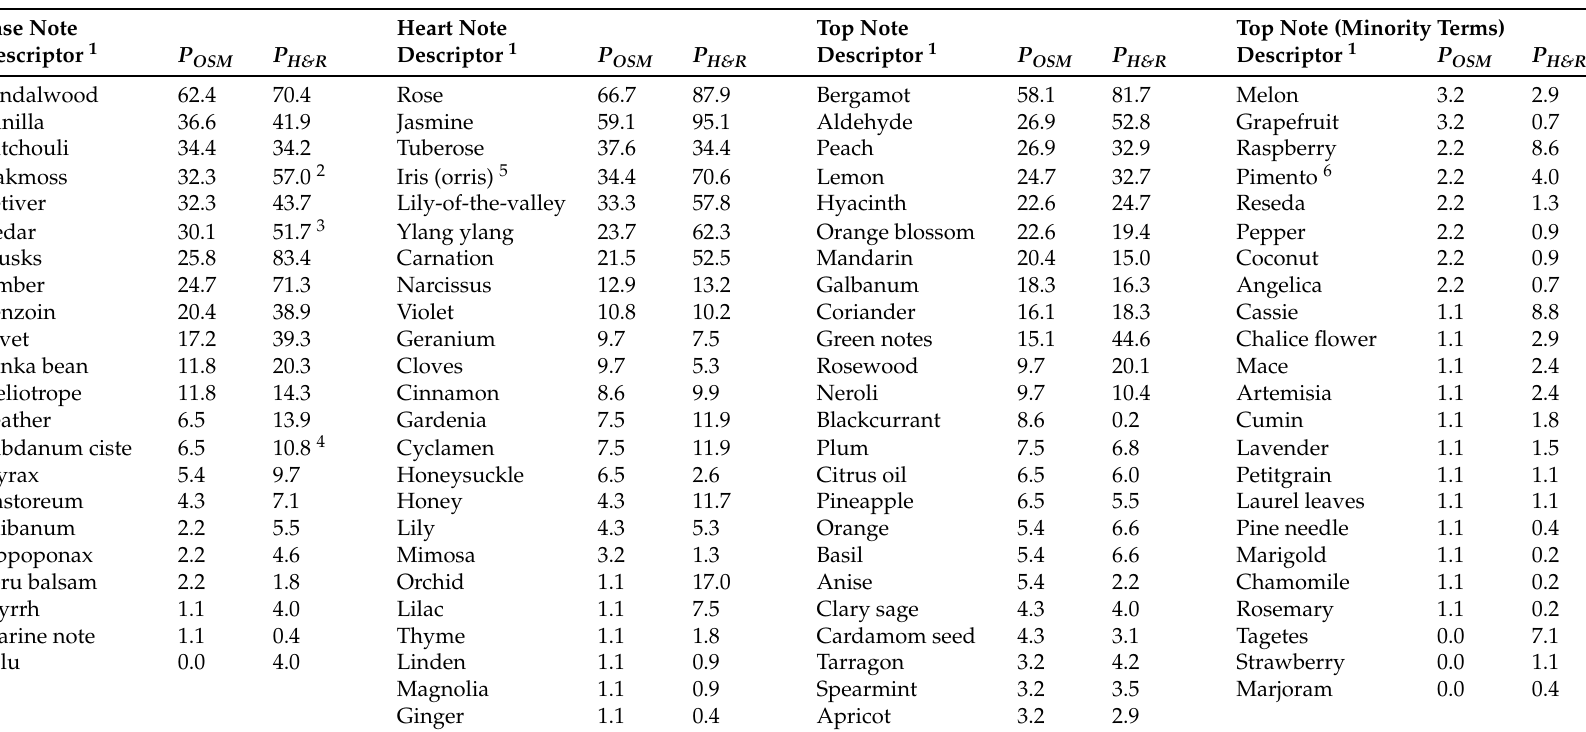
Table 3. Relative frequency of occurrence ( P OSM : in percentage) of terms used by Osmoz to describe the top, heart, and base note (olfactory pyramid) of 93 women’s perfumes. The percentage of these terms used to describe all 453 feminine fragrances contained in the H&R guide is also shown ( P H&R